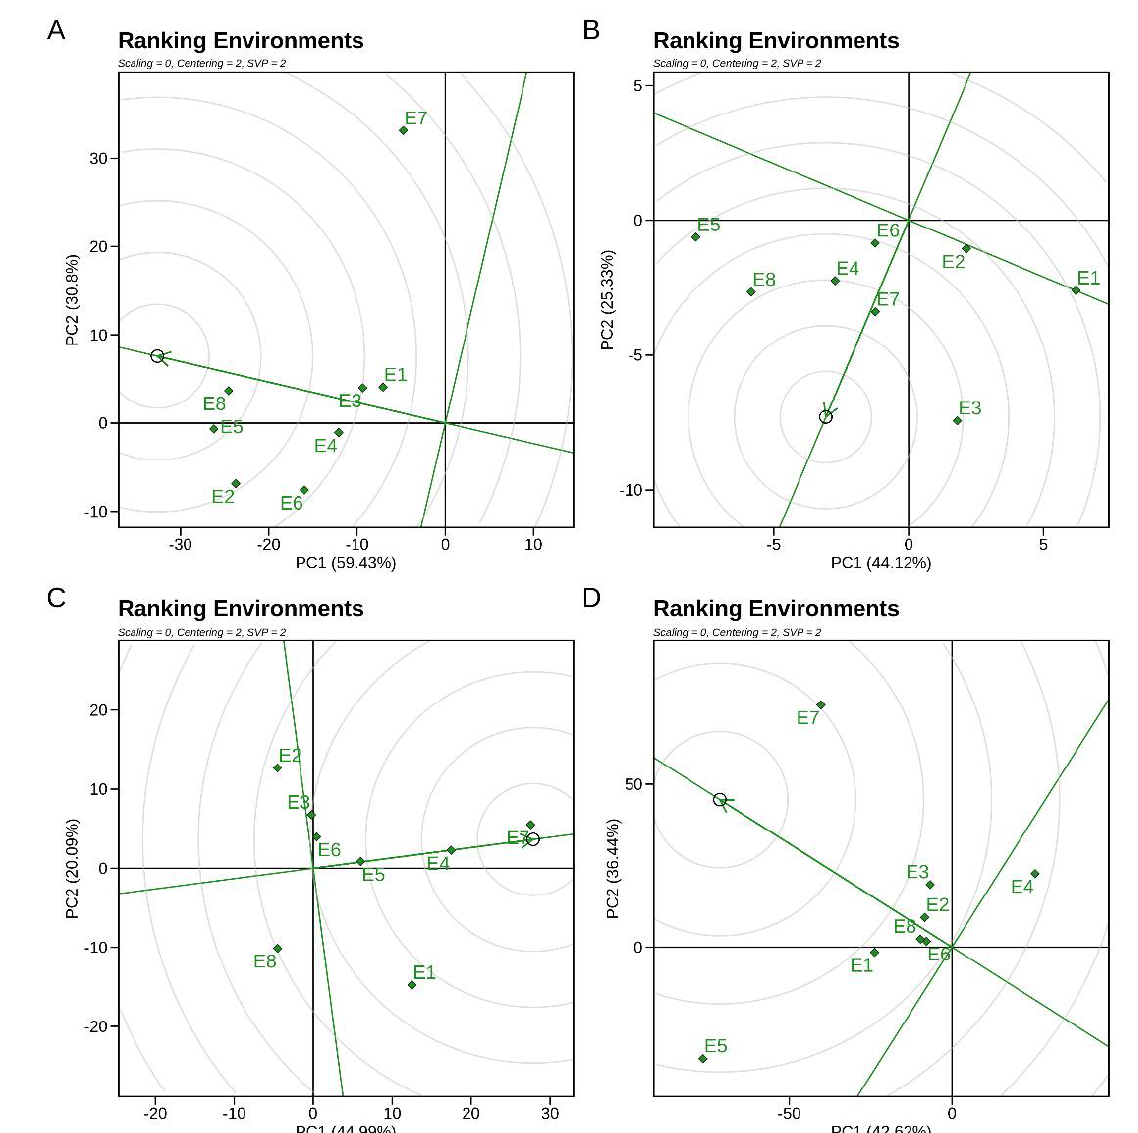
Figure 7. The GGE biplot ‘Ranking environments’ pattern to rank environments for an ideal environment of 5 GSR lines and 2 control lines grown under eight environments in the year 2021 for ( A ) plant height, ( B ) the number of tillers, ( C ) grain yield, and ( D ) straw yield. The biplots were created with centering = 0, SVP = 2, and scaling = 0 parameters.